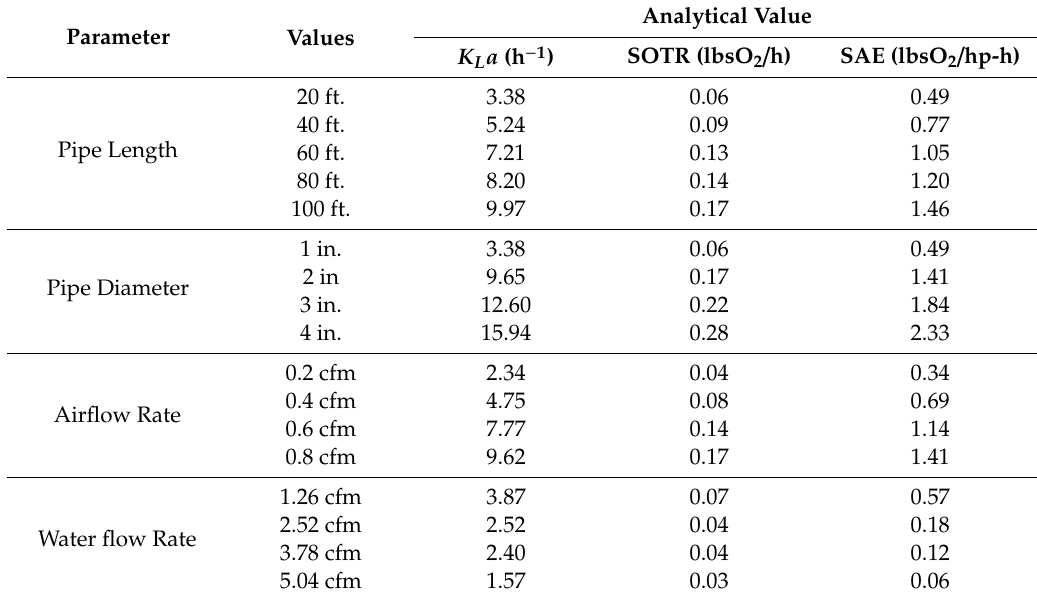
Table 4. Performance of different aeration conditions obtained from the analytical model. Analytical Value Parameter Parameter Values 20 ft. Pipe Length